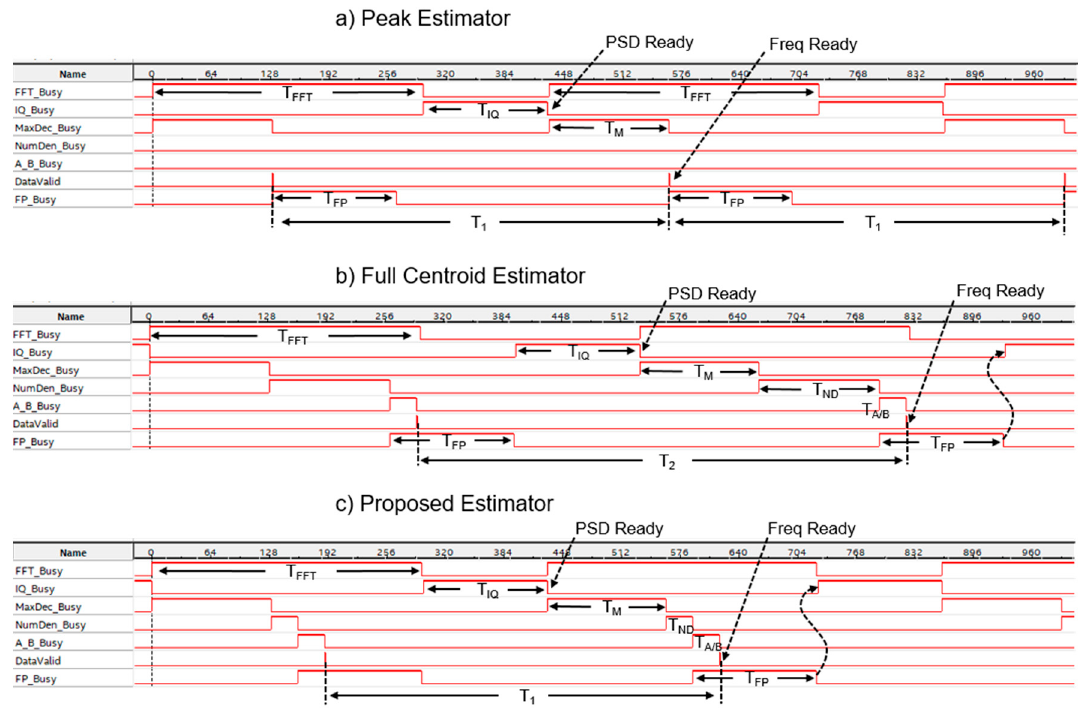
Figure 7. Throughput of the processing chain of Figure 4 for ( a ) the Peak, ( b ) Full centroid and ( c ) proposed frequency estimators. The “busy” signals represent status of the corresponding processing block. The DataValid is asserted when the Doppler frequency estimate is ready.